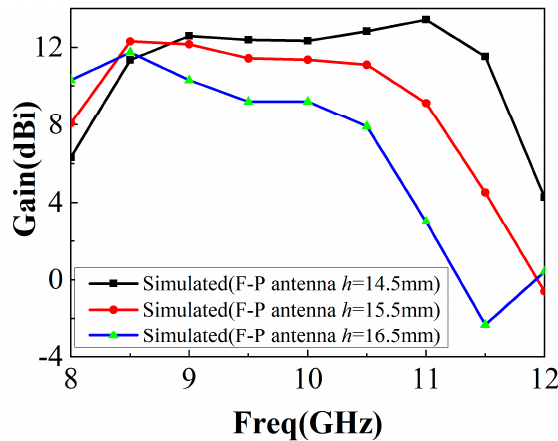
Figure 21. Simulation of F-P resonator antenna gain as a function of h .